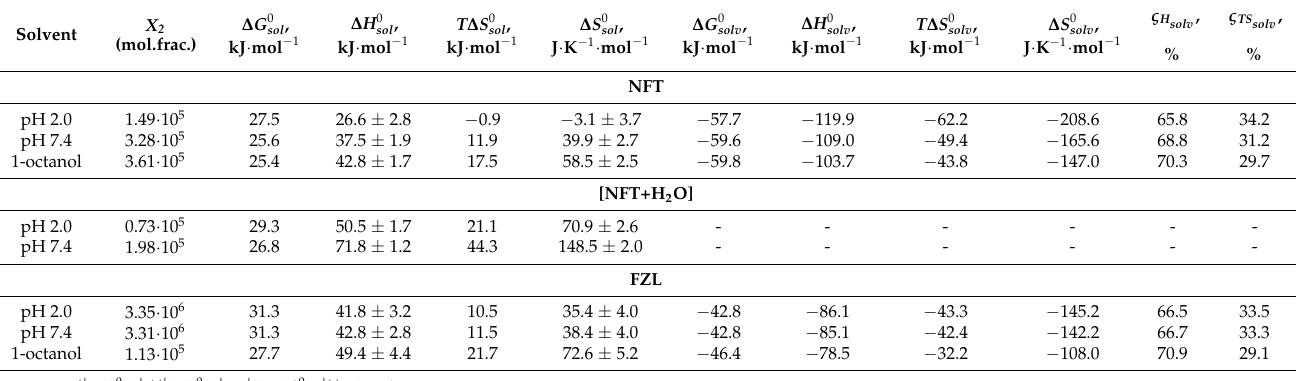
where Y —thermodynamic function ( G —Gibbs energy, H —enthalpy, S —entropy) of solva- tion (solv), dissolution (sol) and sublimation (sub) processes. Table 5. Thermodynamic functions of solubility and solvation processes of NFT and FZL in solvents studied at 298.15 K. X 2 Solvent (mol.frac.)